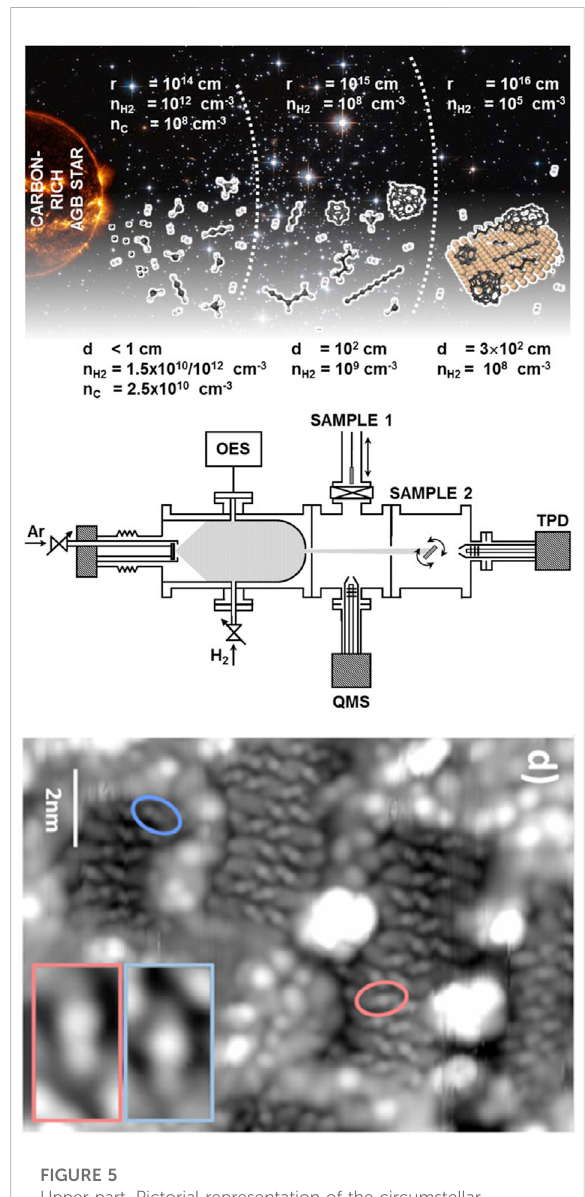
FIGURE 5 Upper part. Pictorial representation of the circumstellar envelope of a carbon rich AGB star with typical densities of carbon (n c ) and hydrogen (n H2 ) at given distances from the central star (r). Middle part: scheme of the Stardust machine with typical densities ofcarbonandhydrogenatagiven distance ofthecarbon target (d). Left: aggregation zone with optical emission spectroscopy (OES). Middle: expansion zone, with quadrupole mass spectroscopy (QMS) and sample collection (S1) for ex-situ diagnosis. Right: analysis area with sample holder (S2) and thermal programmed desorption (TPD). Lower part: In-situ recorded scanning tunneling microscopy (STM) images of carbon clusters deposited on a gold surface at position S2. Reproduced from Martínez et al., 2020, Nat. Astron. 4,